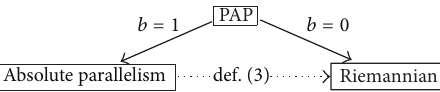
Figure 1: AP and Riemannian spaces as special cases of the PAP-